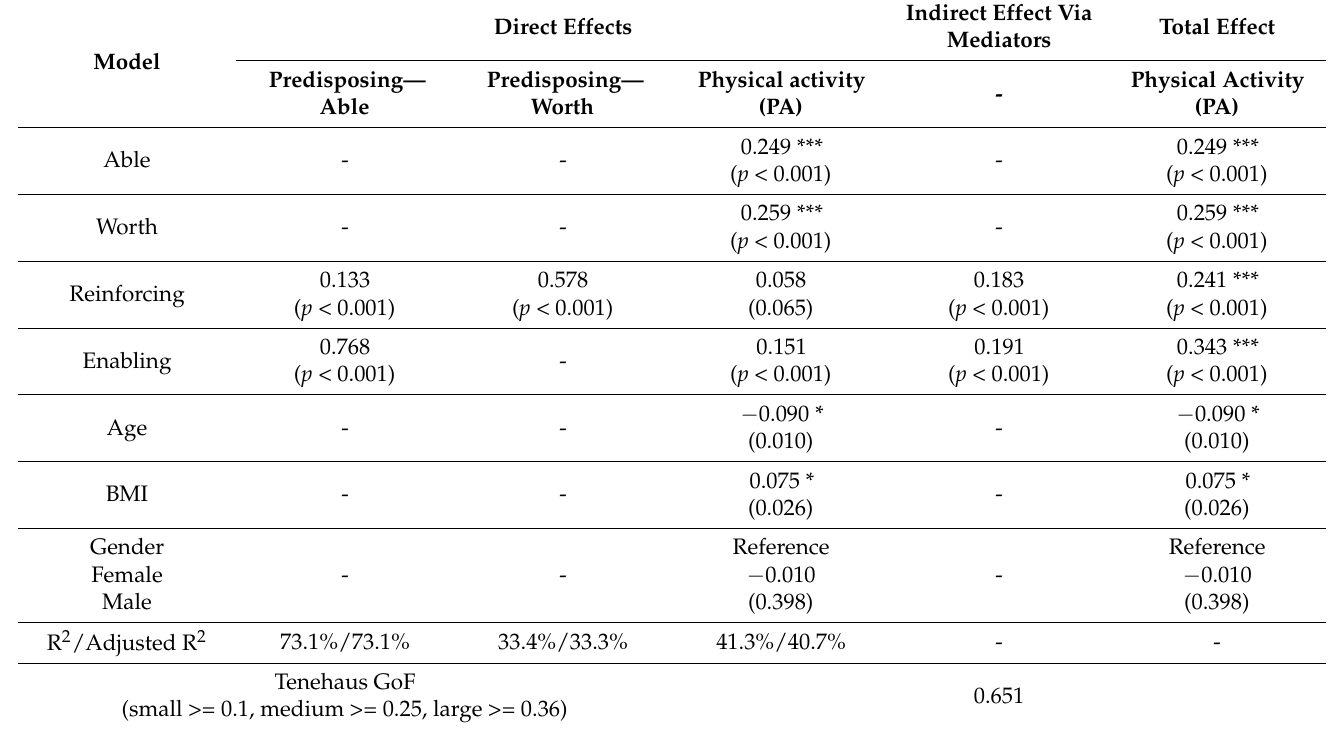
Table 5. Estimated coefficients of the model with two mediators, explaining PA under the assumption of linear relationships.